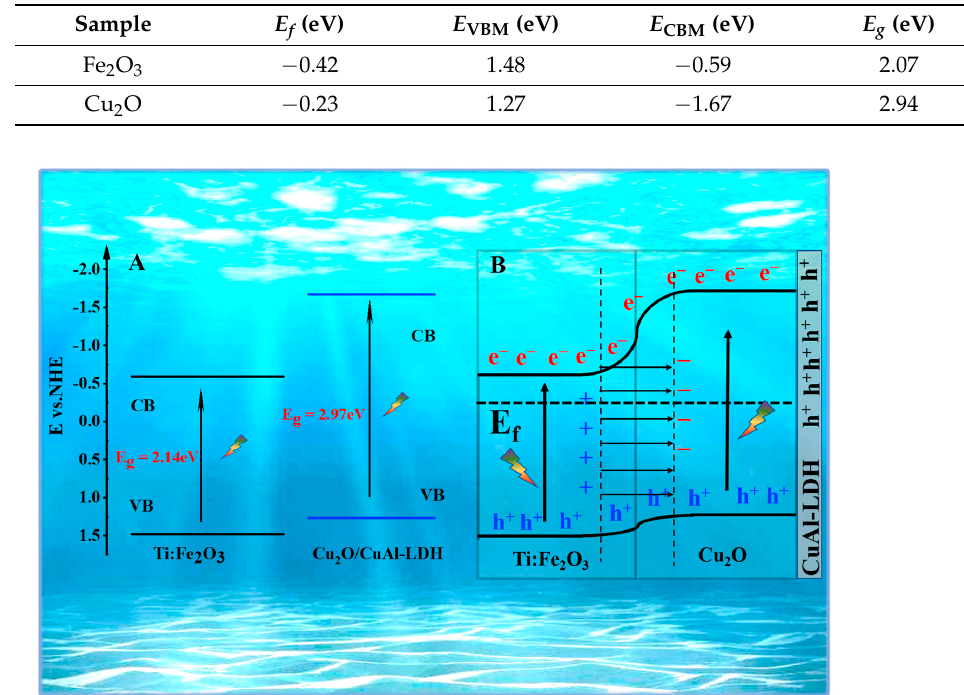
Figure 7. ( A ) Band structure of Ti:Fe 2 O 3 and Cu 2 O, ( B ) possible reaction